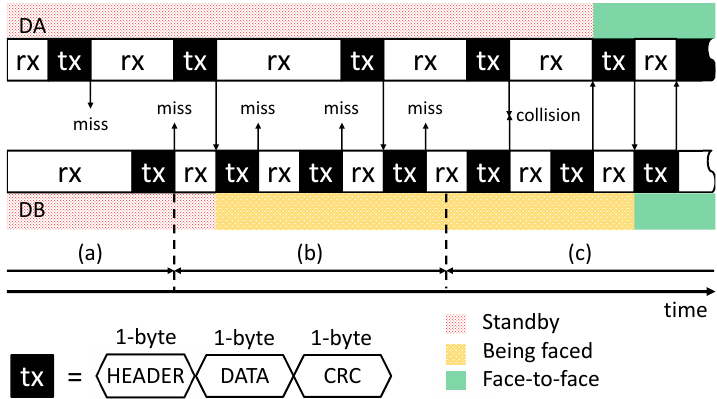
Figure 7. Illustration of communication procedure between Device A (DA) and Device B (DB) in Figure 4. The packet contains a header, data (e.g., device ID), and the